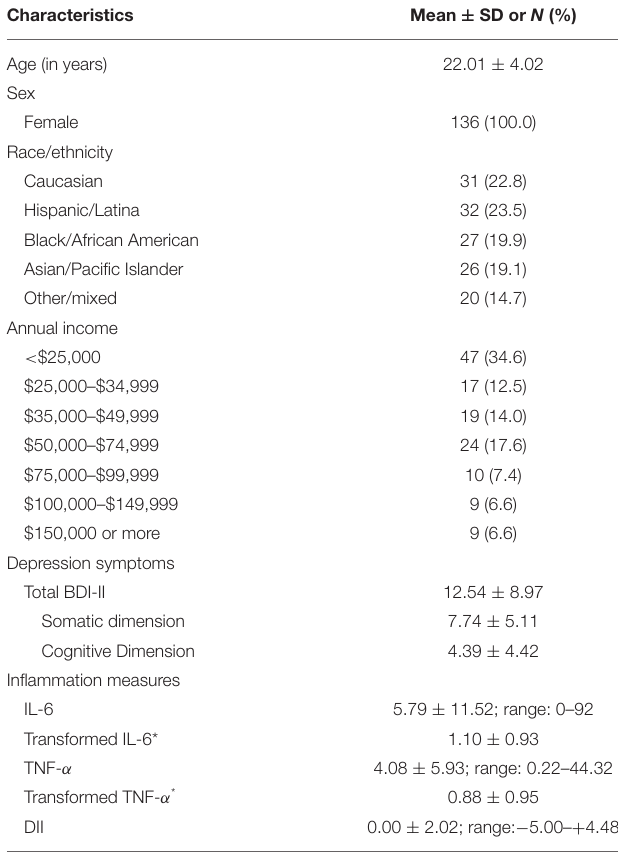
TABLE 1 | Participants’ demographic characteristics ( N = 136).